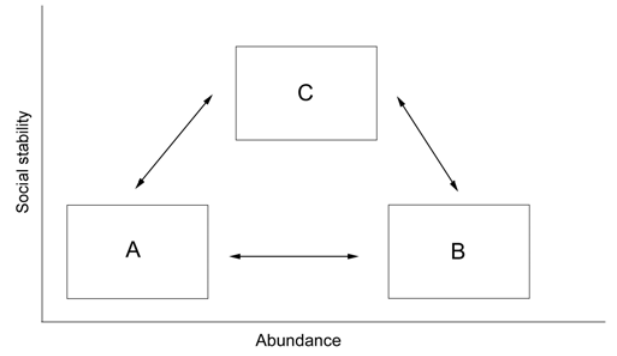
Figure 1. Theoretical model of the relationship between dingo abundance and social